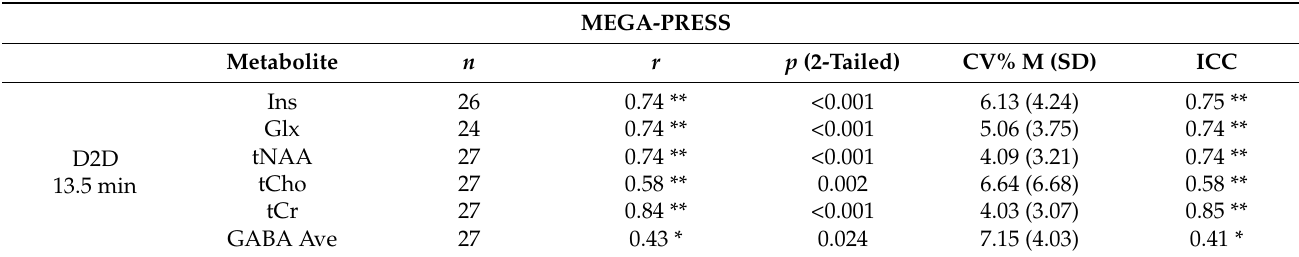
Table 6. Reproducibility metrics obtained for D2D when the average B2B values are used; thus, these are values for an equivalent of 13.5 min scan time. CV is given as M(SD)) with values computed across subjects. Correlation metrics, r , and ICC, are given, with their significance indicated by the